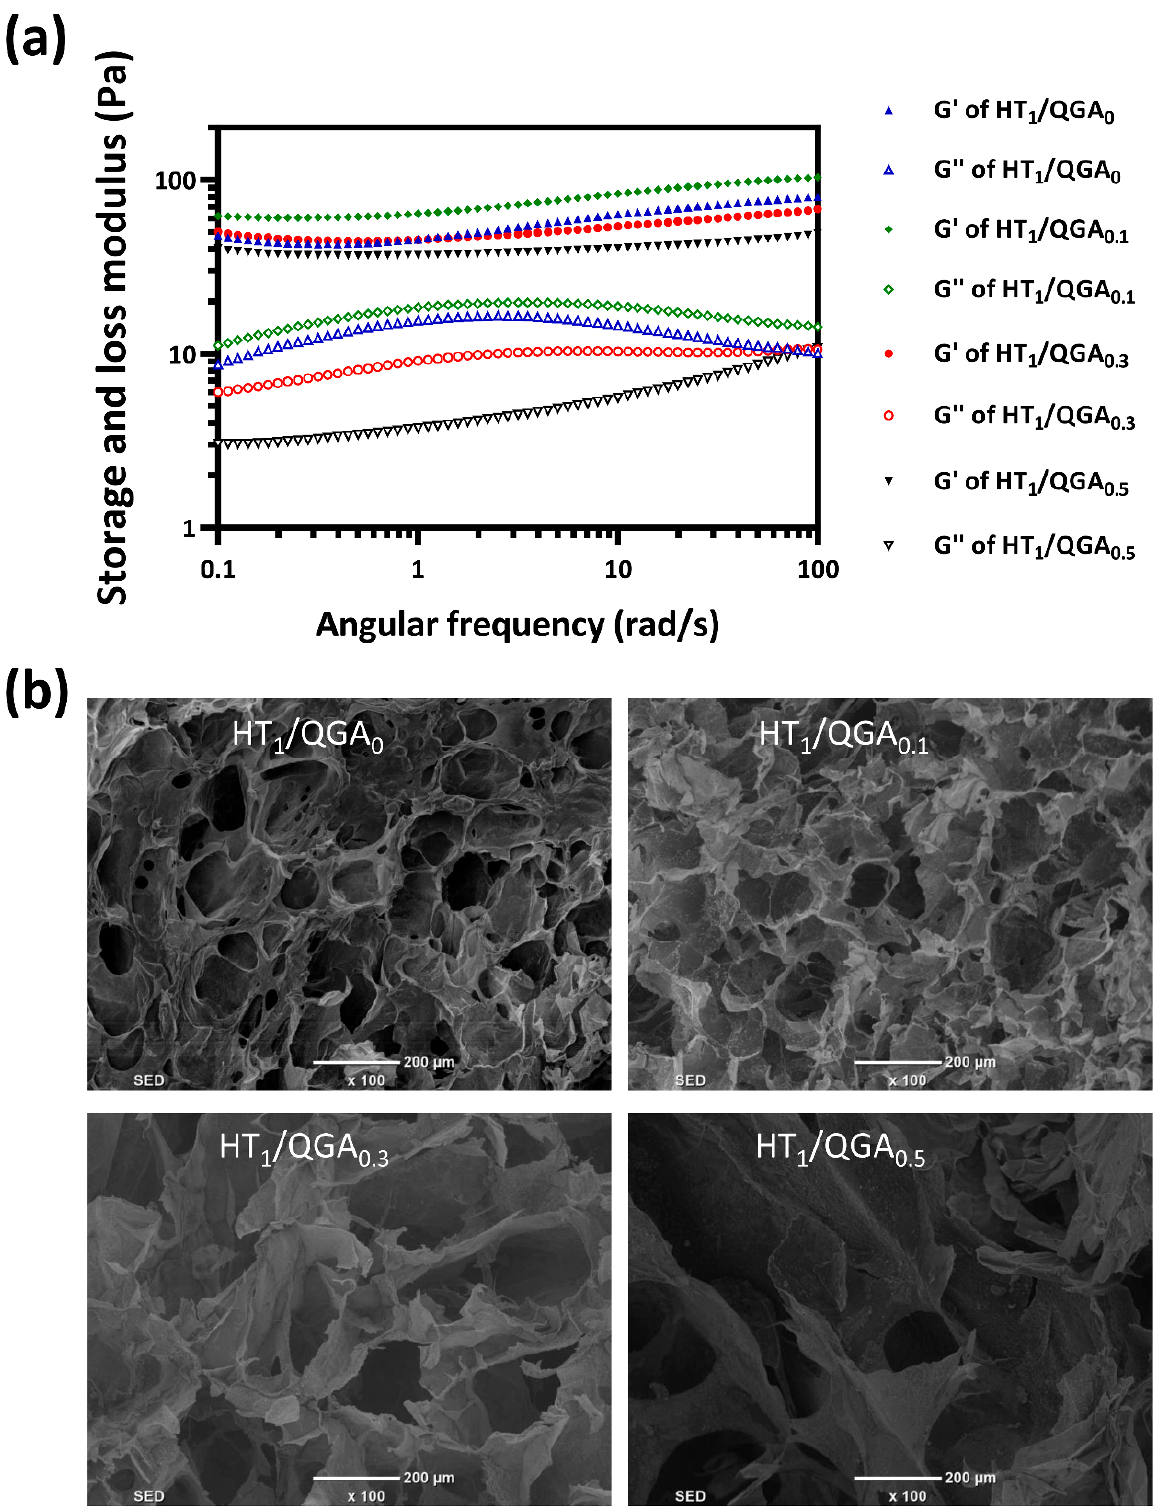
Figure 3. ( a ) The rheological properties of HT/QGA hydrogel; ( b ) the morphology of HT/QGA measured by SEM.